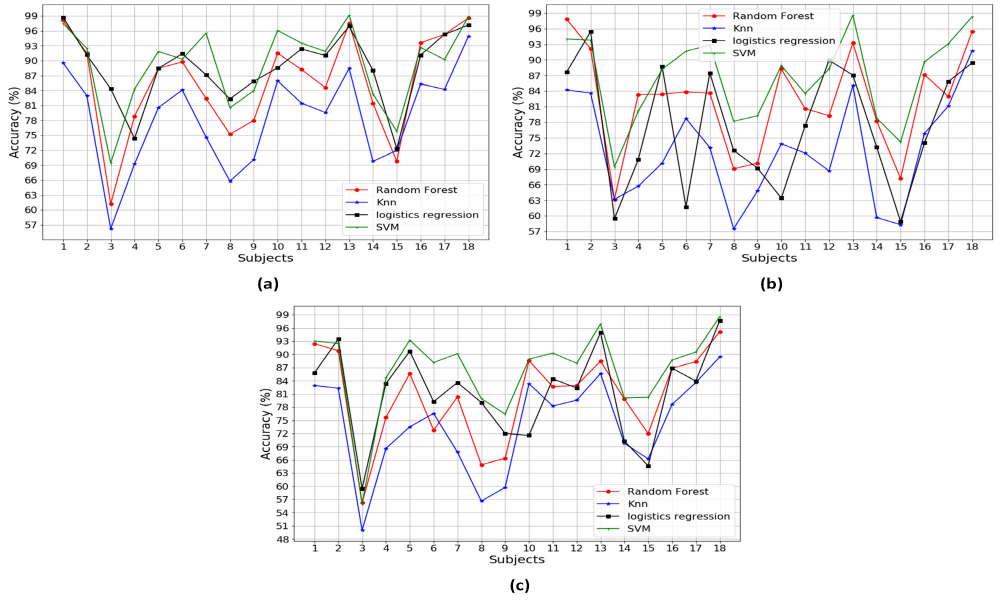
Figure A2. The average accuracy performance over a combination of two types of sensors: ( a ) accuracy over Pre+Acc; ( b ) accuracy over Pre+Gyro; and ( c ) accuracy over